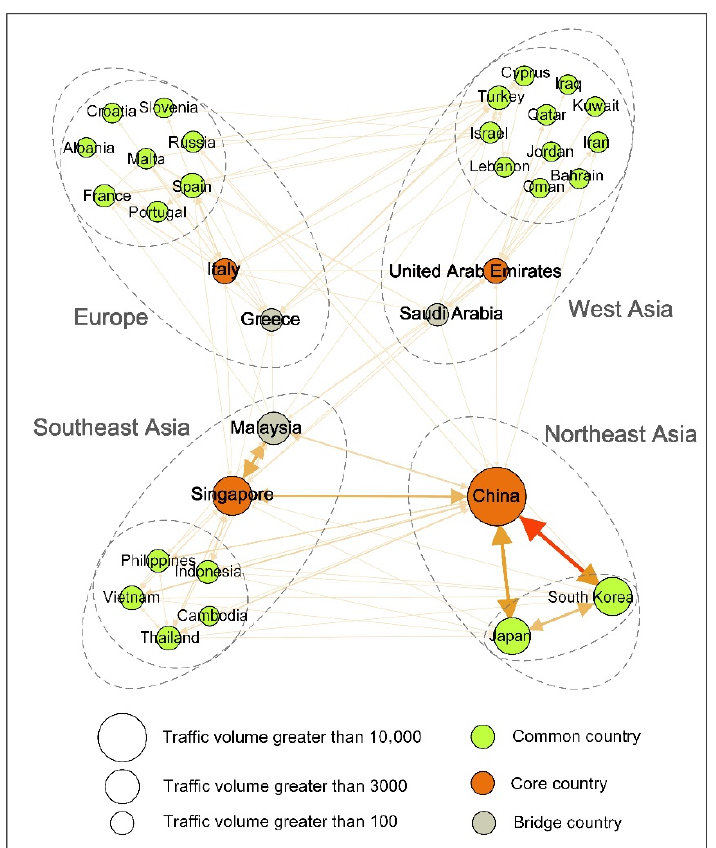
Figure 8. Role assessment of countries in the Maritime Silk Road traffic. The visualization is made by Gephi.